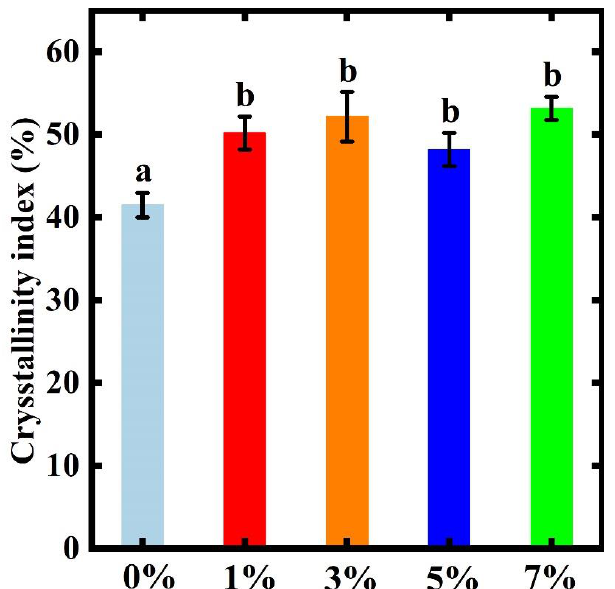
Figure 7. The crystallinity index of different PLA/coffee grounds 3D printing materials. Lowercase letters indicate significant differences between groups ( p < 0.05). The error bar represents the standard deviation.